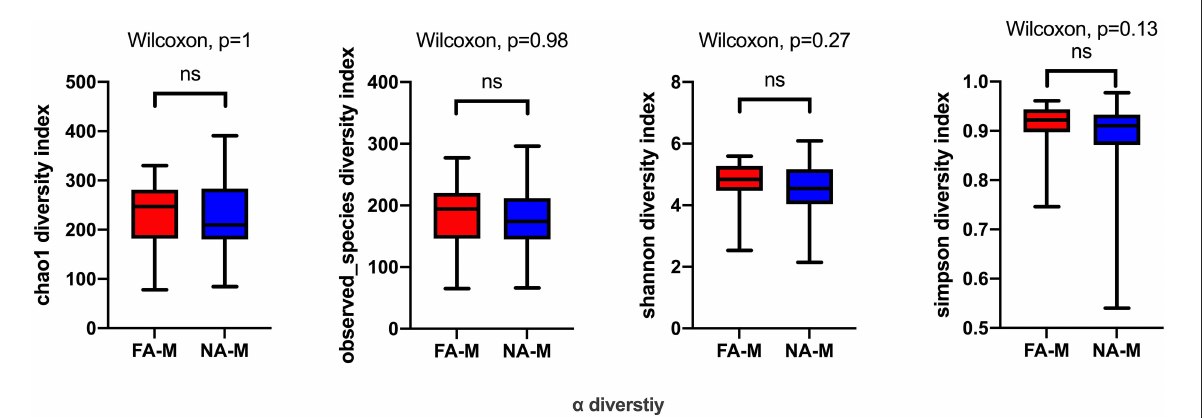
FIGURE1 Differences in the alpha diversity of maternal samples between the non-allergy (NA) and food allergy (FA) groups, as measured by different measure indices. Chao1 and Observed_species indices reflect species richness, and Shannon or Simpson indices reflect species diversity. ns, not